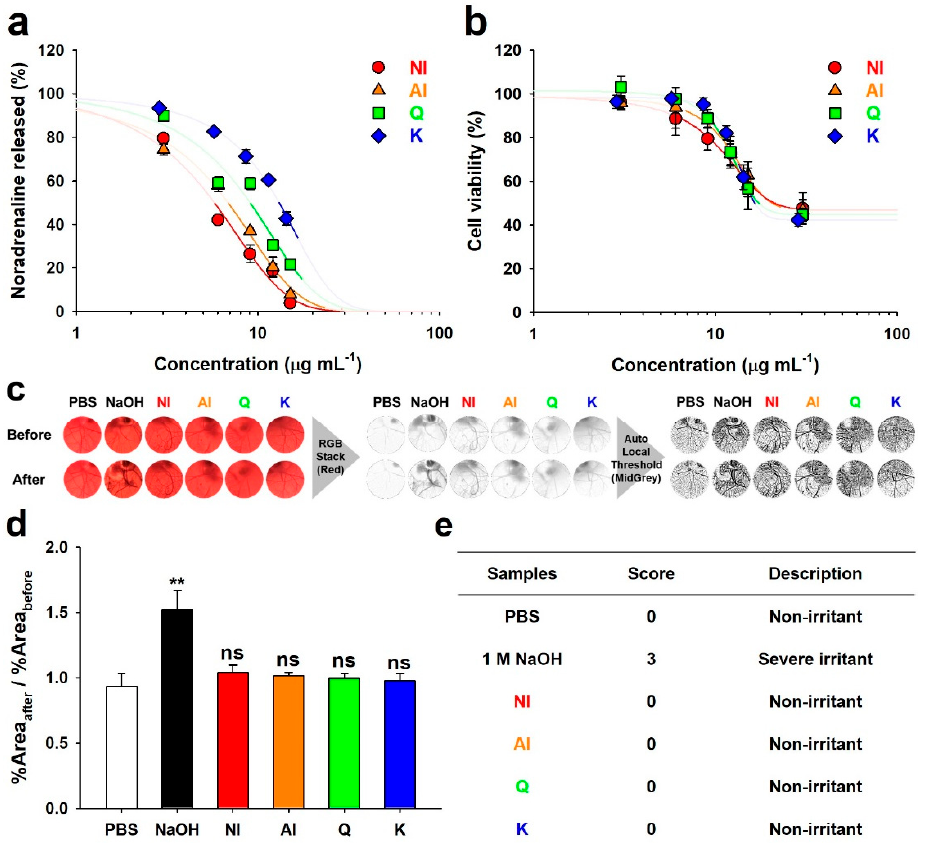
Figure 4. Neurotransmission inhibitory e ffi cacy and safety of the non-hydrolyzed isolate (NI) and acidolyzed isolate (AI) of Ginkgo biloba leaf, quercetin (Q), and kaempferol (K). ( a ) Inhibition of norepinephrine release from the di ff erentiated PC-12 cells by NI, AI, Q, and K. ( b ) Cytotoxicity of NI, AI, Q, and K towards the PC-12 cells. Thick lines on the fitting curves represent the region